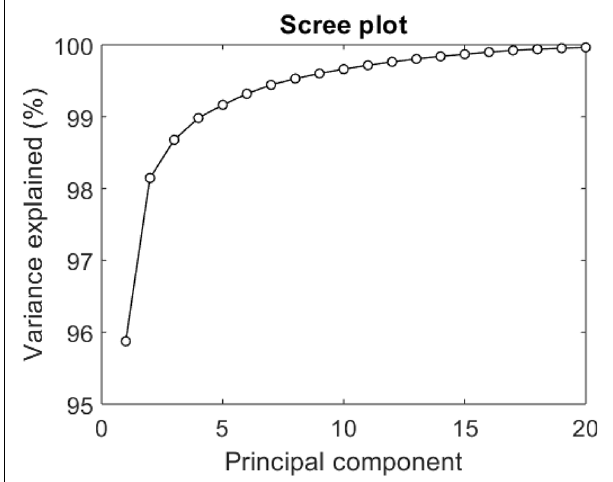
FIGURE 3 | Scree plot for assessing cumulative variance explained by additional functional principal components